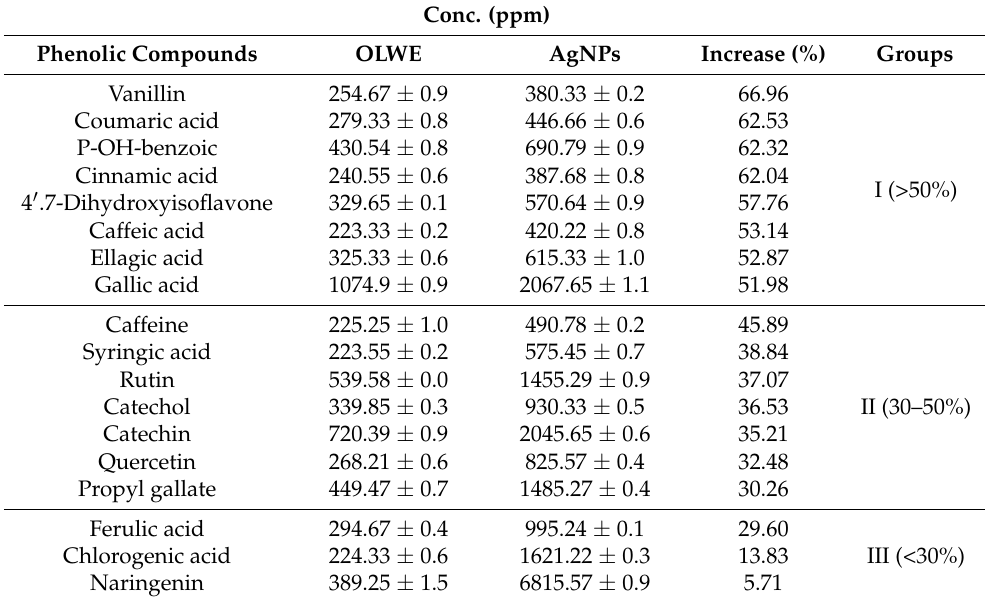
Table 1. Phenolic compound profile of the AgNPs and OLWE.